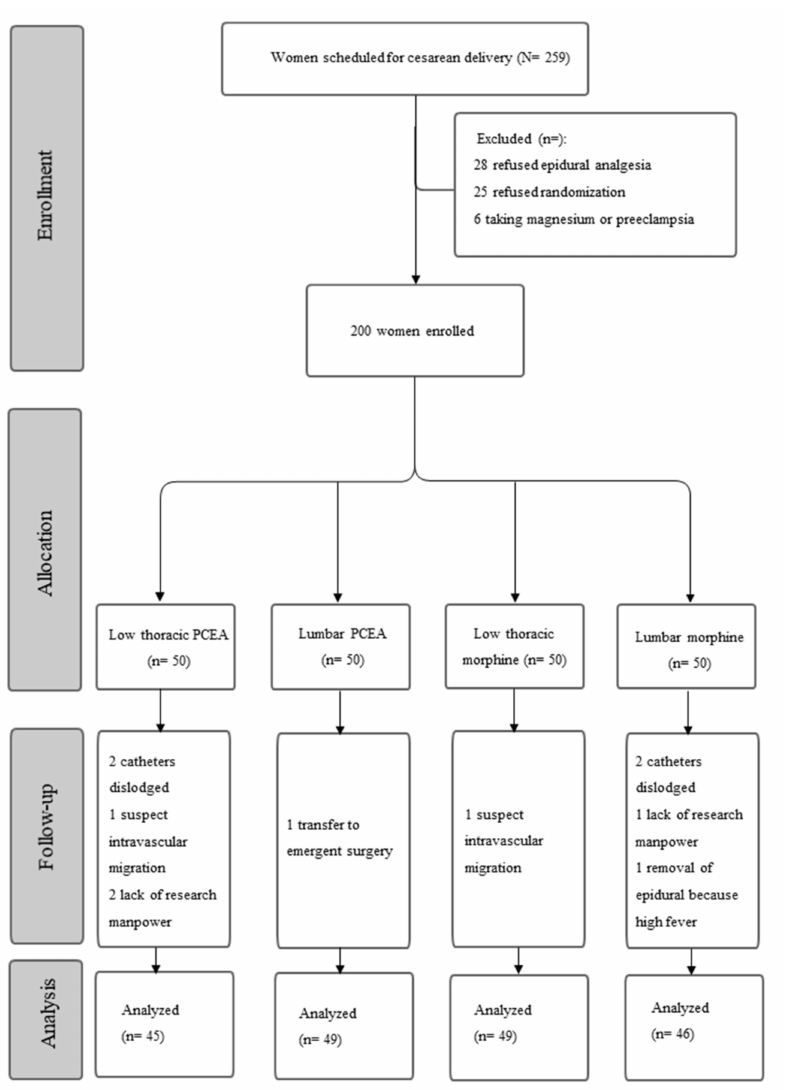
Figure 1. CONSORT